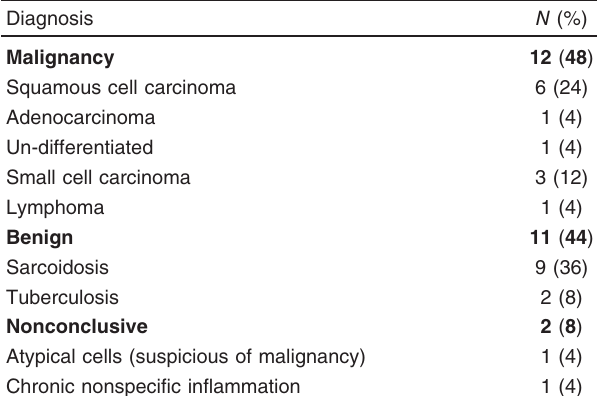
Table 3 Final histopathological diagnosis of the studied cases